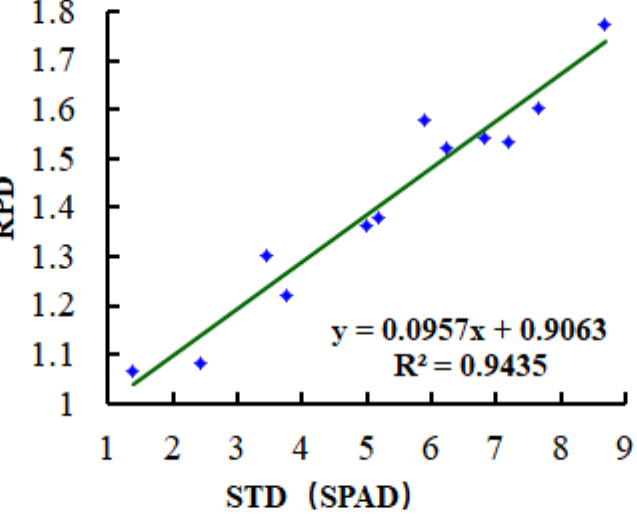
Figure 18. The correlation diagram of model RPD and STD of sample SPAD values.